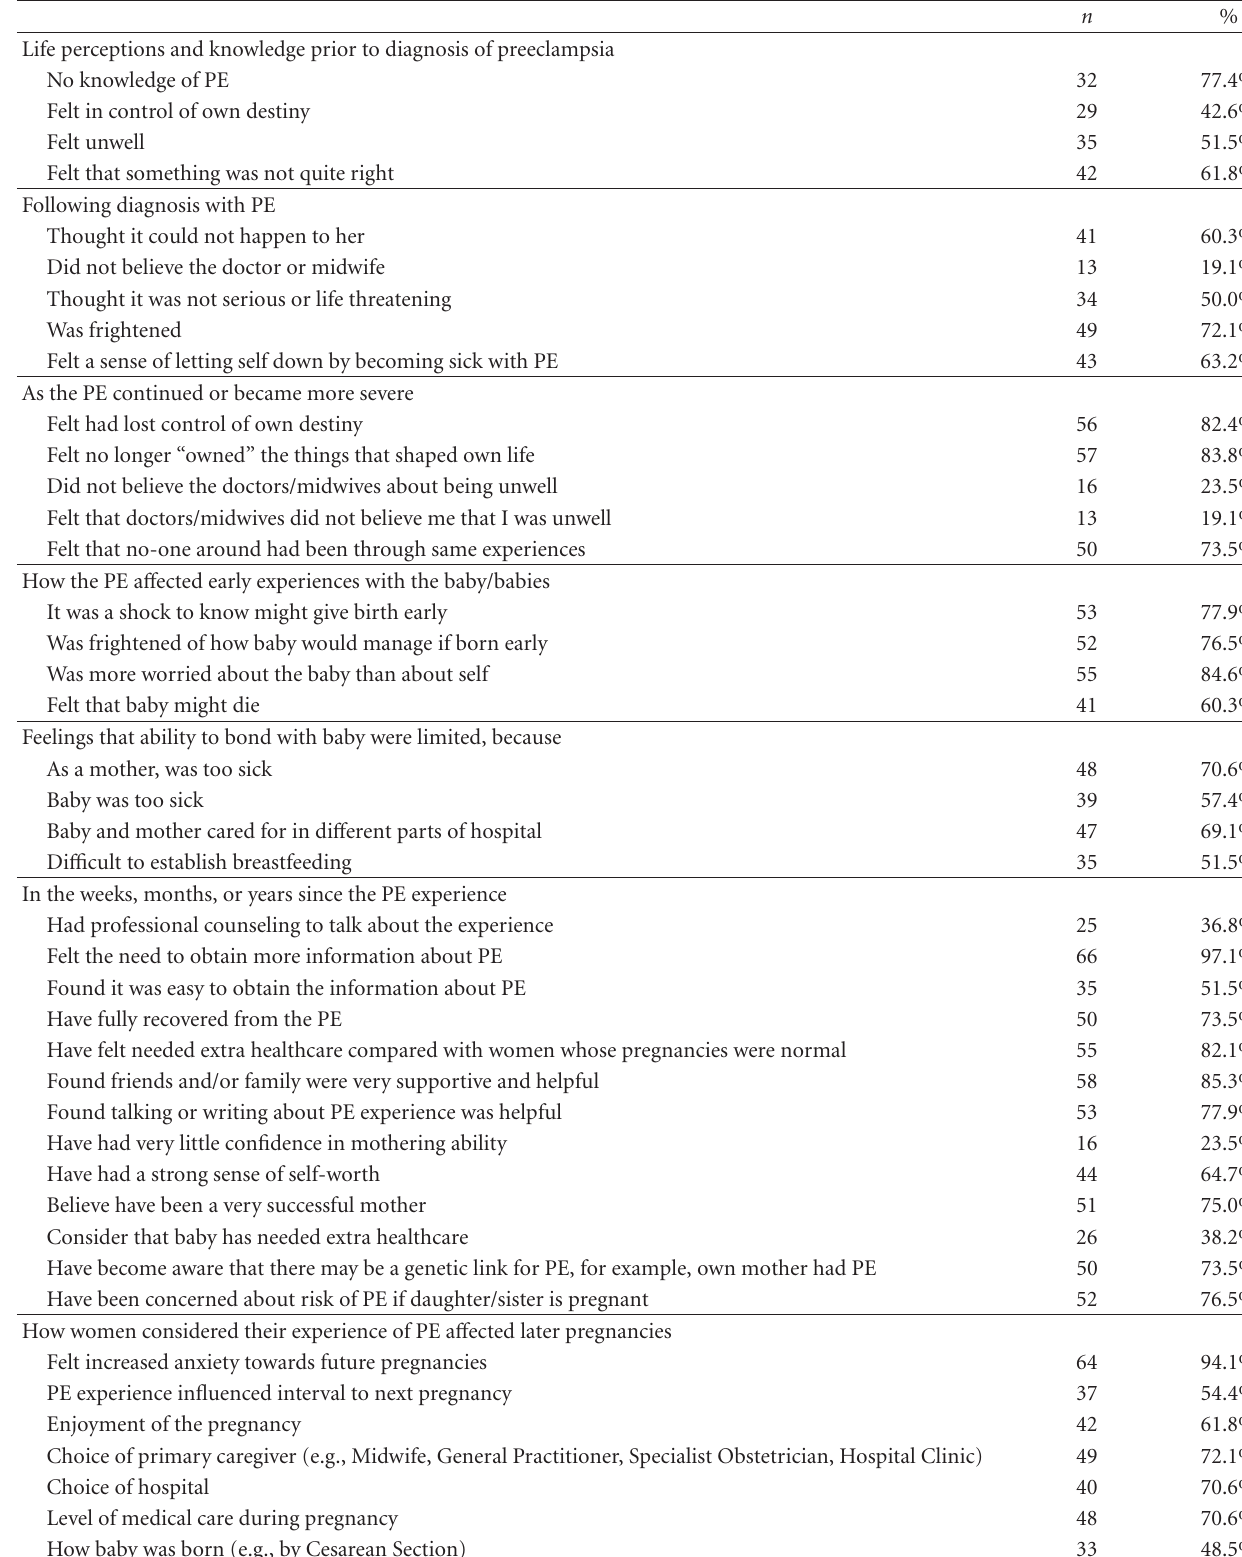
Table 2: Women’s reported perceptions of their PE ∗